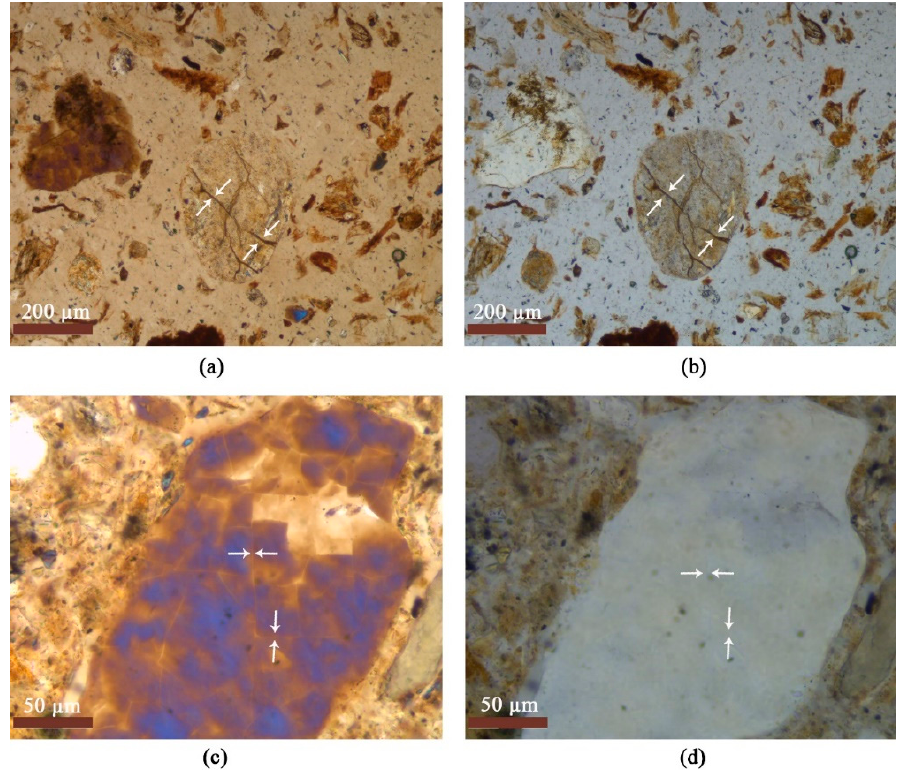
Figure 15. Contact void due to cryogenic processes in the soils. Quartz mineral. S 3. ( a , b ) (16–25 cm)) and ( b , c ) (25–31 cm)). ( a , c ) Plane polarized light; ( b , d ) crossed polarized light. Apparently, the micas that are formed here are secondary minerals, while the main primary mineral is feldspars. Organic residues are represented by both organic fine materials and organ tissues.